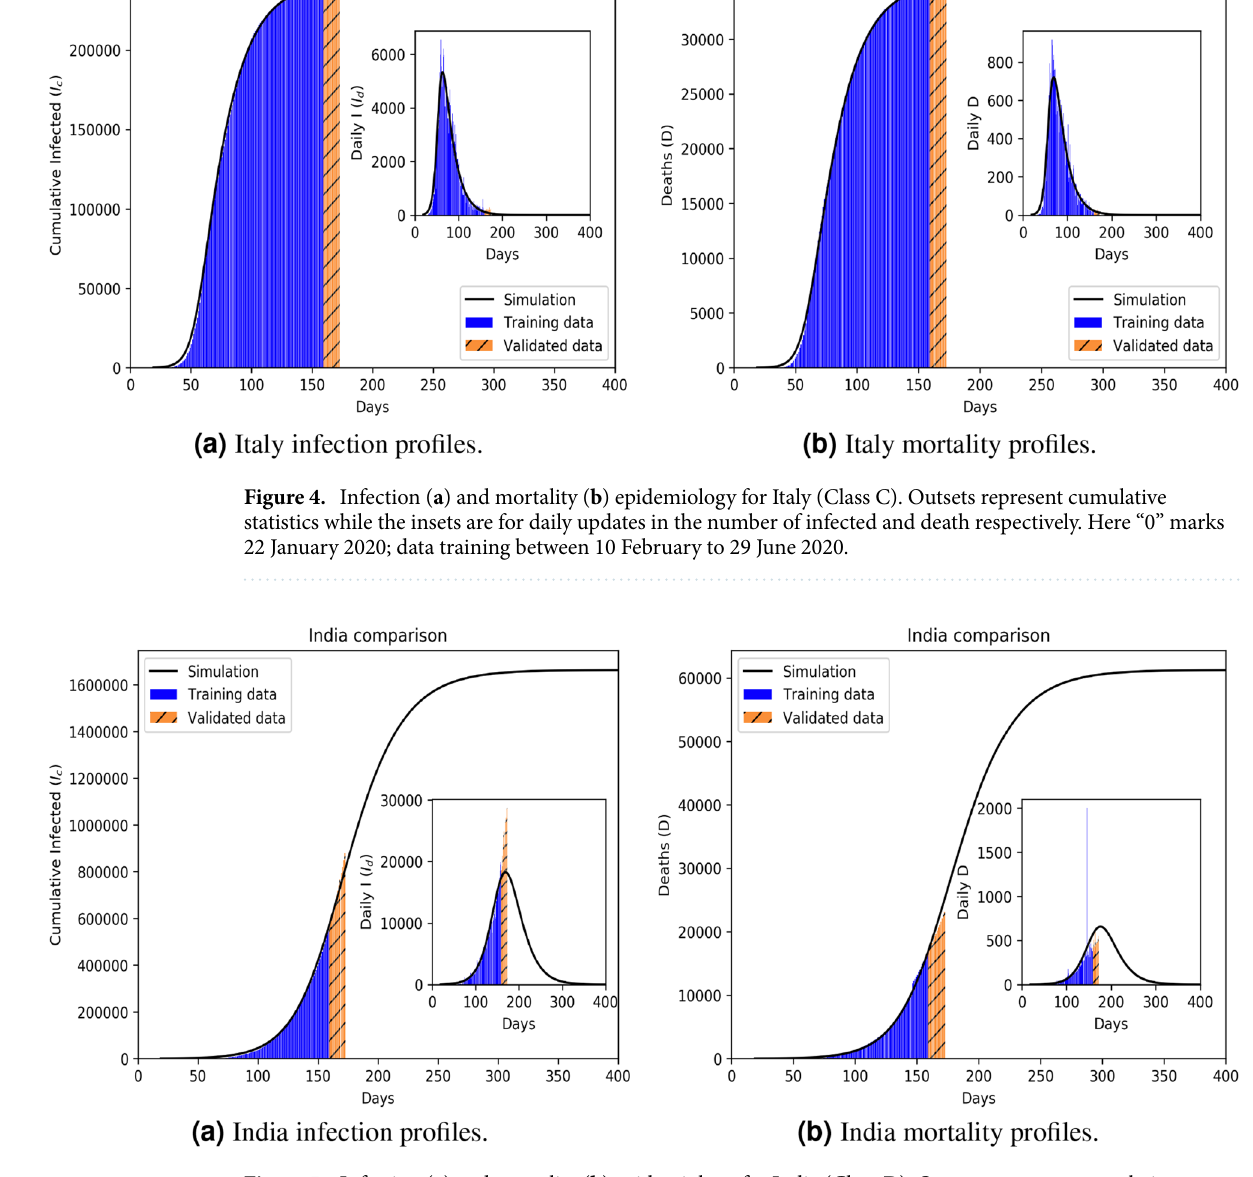
Figure 5. Infection ( a ) and mortality ( b ) epidemiology for India (Class D). Outsets represent cumulative statistics while the insets are for daily updates in the number of infected and death respectively. Here “0” marks